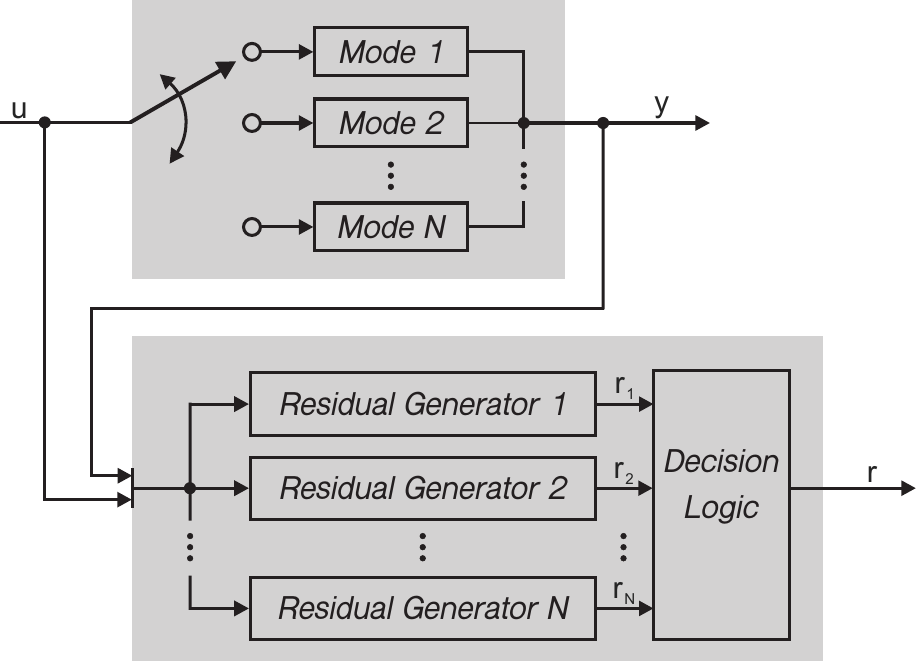
Figure 2. Schematic diagram of fault dection for switched systems proposed in this